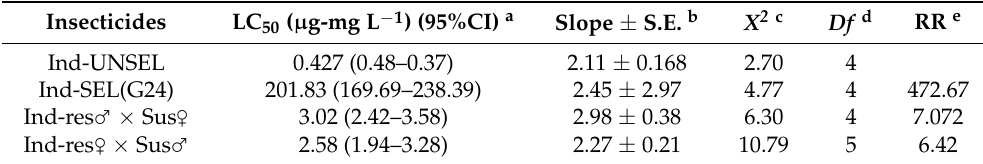
Table 2. Concentration mortality (LC; µ g mL − 1 ) response of S. frugiperda strains and crosses to the insecticide indoxacarb after 24 generations of